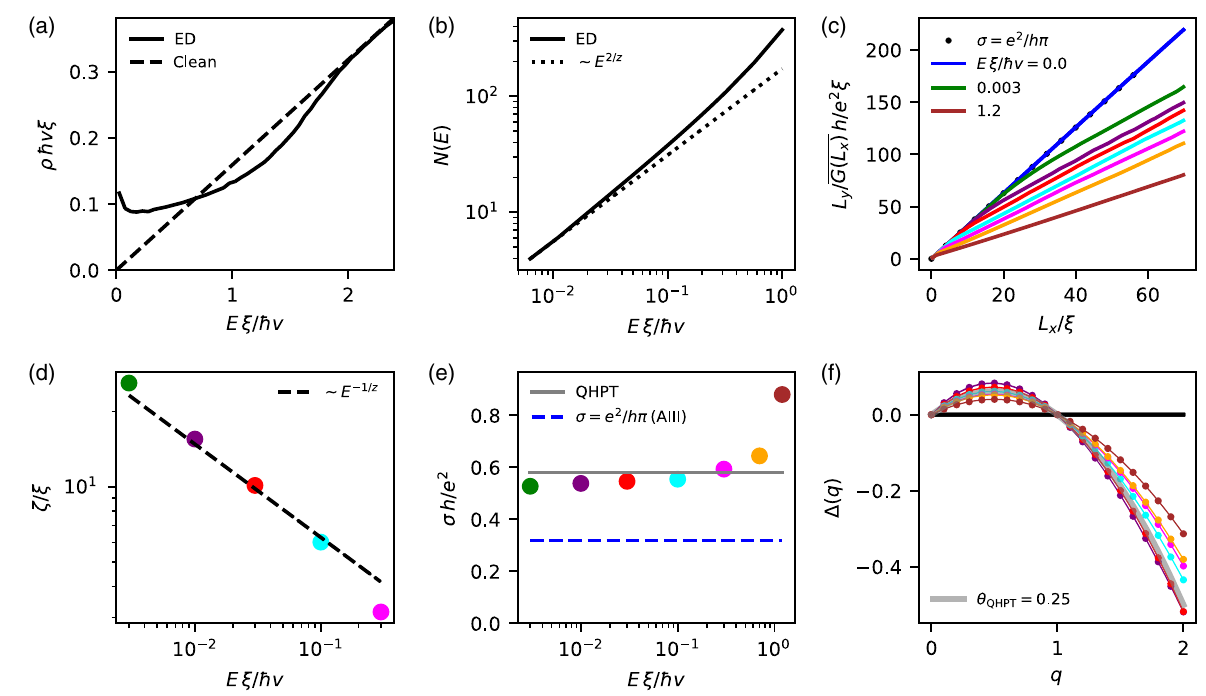
FIG. 2. Numerical results for the topological class AIII surface model with a single Dirac node ( ν ¼ 1 ), defined by Eq. (7) and protected by the “ anomalous ” chiral symmetry in Eq. (5). The random vector potential strength is W ¼ 2 . 3 [Eq. (16)]. (a) The DOS ρ ð E Þ versus energy, as calculated from ED (100 disorder realizations), is most strongly affected by disorder around the Dirac point ( E ¼ 0 ). R ϵρ ð ϵ Þ is plotted versus energy. The predicted scaling form implied by Eq. (12) is governed by the E (b) The integrated DOS N ð E Þ ¼ 0 d disorder-dependent dynamical critical exponent z ¼ 1 þ W 2 = π . (c) Quantum transport results for the resistance normalized to system width, averaged over 200 disorder realizations. The energies are from top to bottom E ξ = ℏ v ¼ 0 , 0.003, 0.01, 0.03, 0.1, 0.3, 0.7, 1.2. (d) The crossover scale from the transport calculation scales as the correlation length ζ ∼ E − 1 =z . (e) Conductivities extracted from the slope of the curves in (c) above the crossover scale ζ , compared to the established value of the QHPT critical conductivity. (f) Anomalous part of the multifractal spectrum Δ ð q Þ extracted from box-size scaling of ED eigenstates for box sizes beyond the correlation length ζ , as determined in (d). The data correspond to E ξ = ℏ v ¼ 0 . 01 , 0.03, 0.1, 0.3, 0.7, 1.2 (bottom to top at q ¼ 2 ) and are based on 100 disorder